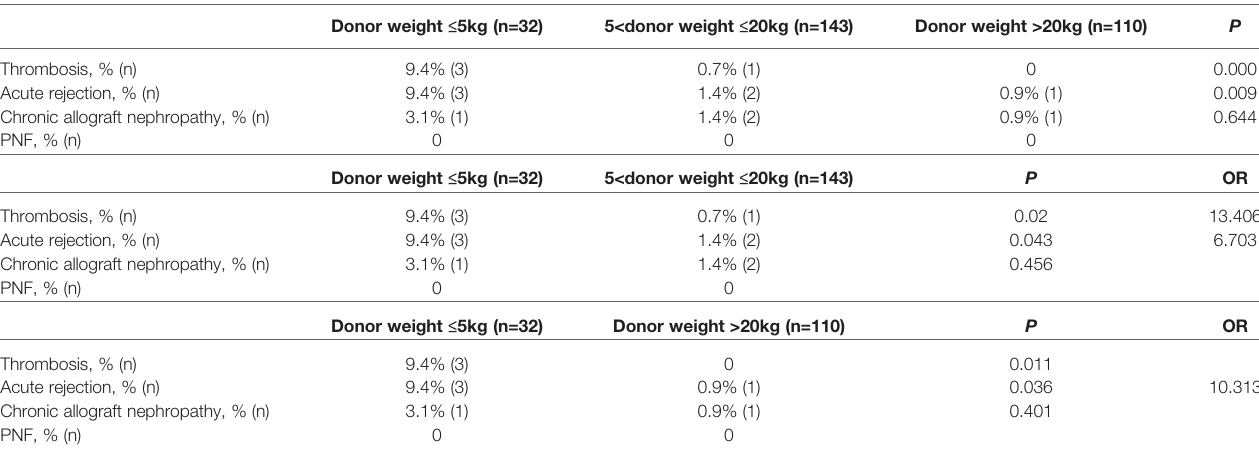
TABLE 3 | Causes of graft